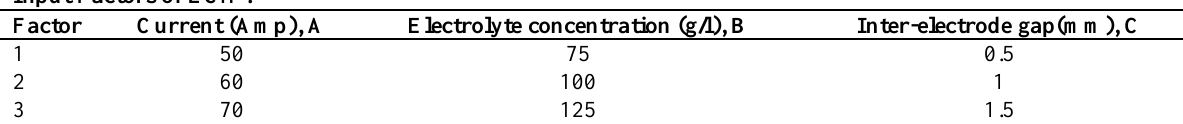
Input Factors of ECM.